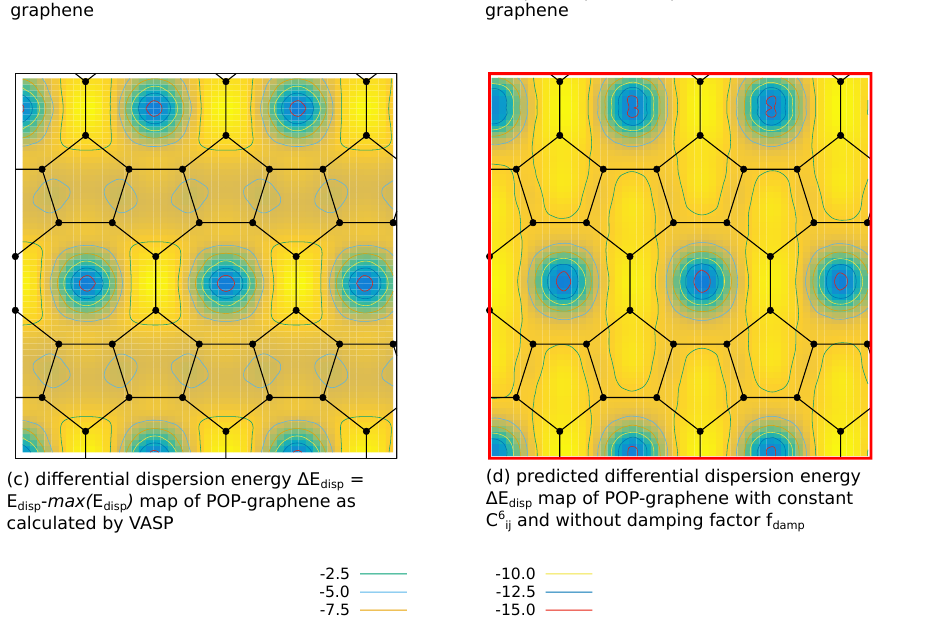
Figure 4. Contributions to the adsorption energy maps. ( a ) pure PBE-GGA energies, ( b ) analytical vdW dispersion according to Equations (4) and (5), ( c ) TS vdW dispersion calculated by VASP, and ( d ) geometry-dictated topology form the ∑ 1/ r ij , L term. The corresponding full adsoprtion energy map is in Figure 3e. Contour lines are plotted every